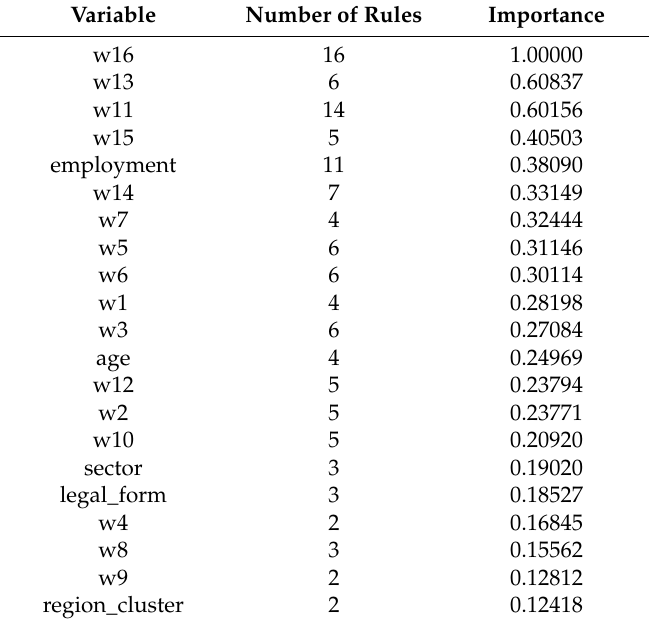
Table 4. Importance of variables in the decision tree.